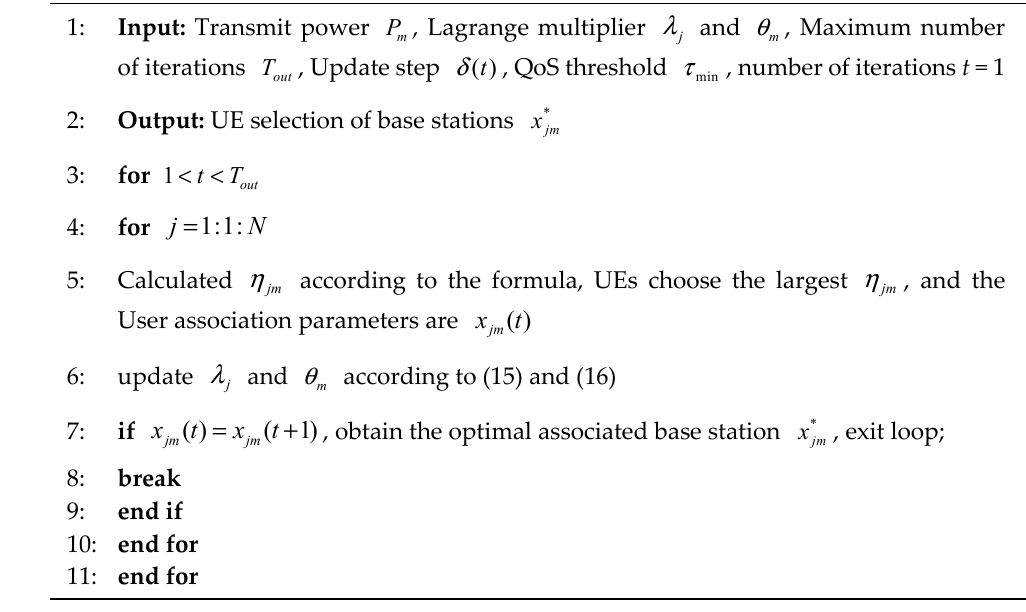
Algorithm 1 Lagrangian-Based User Association Algorithm